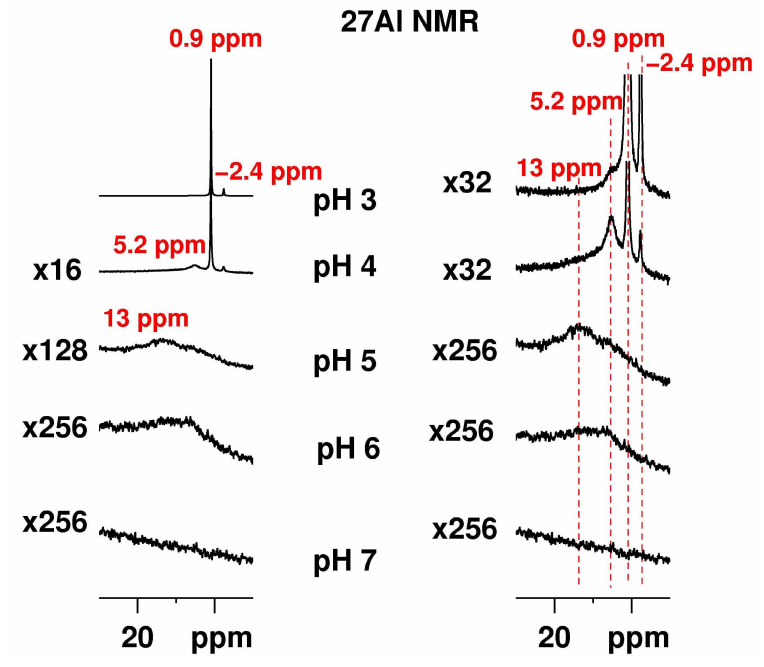
Figure 1. 27 Al NMR solution spectra of Al 2 (SO 4 ) 3 in L1 medium recorded at pH 3 to 7 and scaled to the signal with the highest intensity at 0.9 ppm ( left ) with the spectral region characteristic for the hexa-coordinated Al magnified ( right ). All spectra were recorded without 2 H spin lock as no deuterated solvent was used. For all spectra, the background 27 Al signal due to the glass of the NMR tube was recorded in a separate experiment with the same number of scans and receiver gain and subtracted from the spectrum of the respective